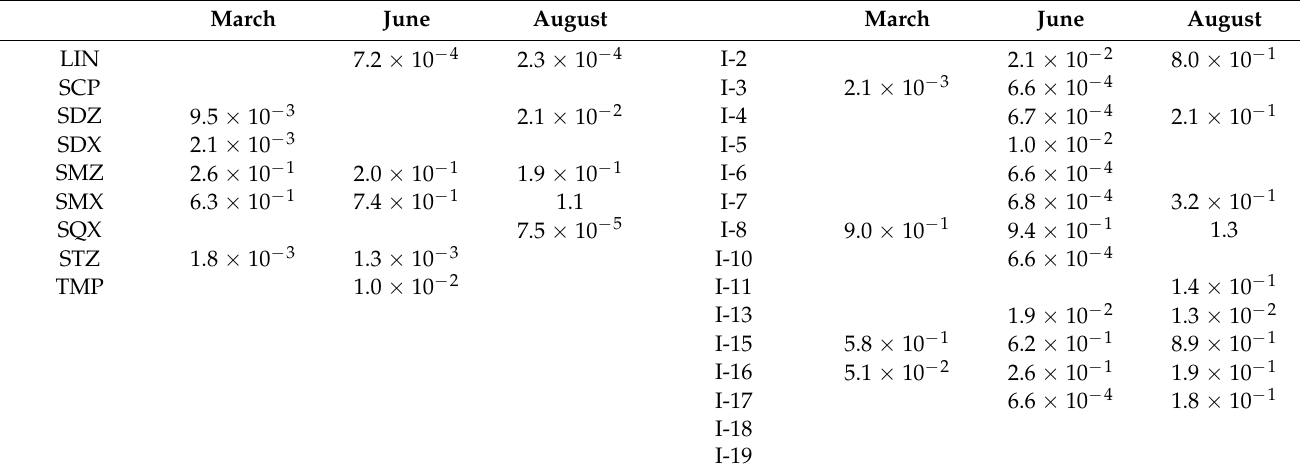
Table A6. Ecological risk assessment for antibiotics in the groundwater samples during each sampling campaign. Blank cells indicate samples where no antibiotic could be detected.